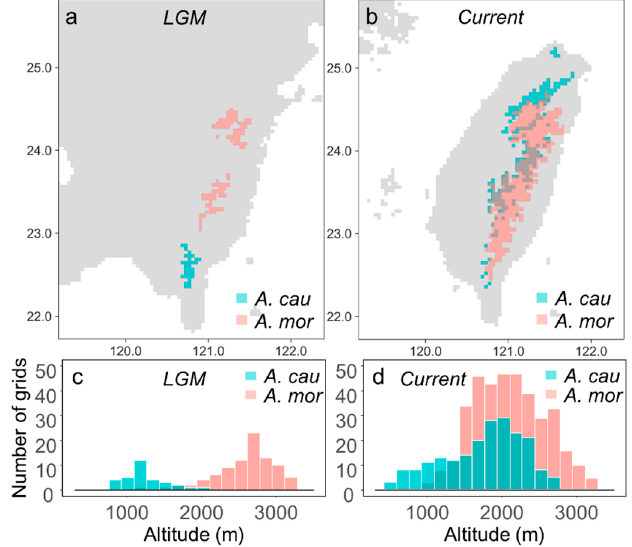
Figure 2. Geographic distributions of Acer caudatifolium and A. morrisonense inferred by ecological niche modeling (ENM). ( a , b ) are the most proper geographic distributions in the Last Glacial Maximum (LGM) and the present, respectively. ( c , d ) denote the altitudinal distribution in the LGM and the present, respectively. The grid numbers of ( c , d ) were counted from ( a , b ), respectively. These plots showed the allopatric distribution of two maples in the LGM and the current parapatric distributions. Data on ENM distributions are adopted from Luo et al. [22] and Chang et al.